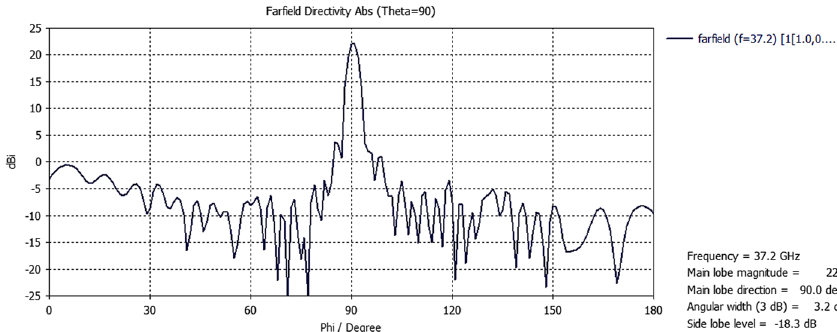
Fig. 10 1-D radiation pattern at frequency F = 37.2 GHz for antenna with non-identical irregularities